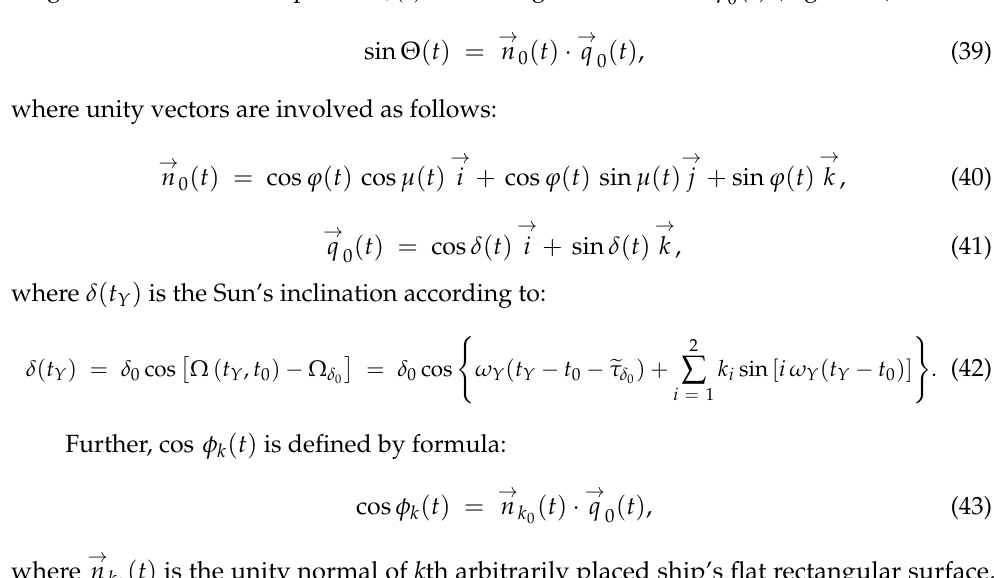
→ n 0 ( t ) and acting Sun radiation